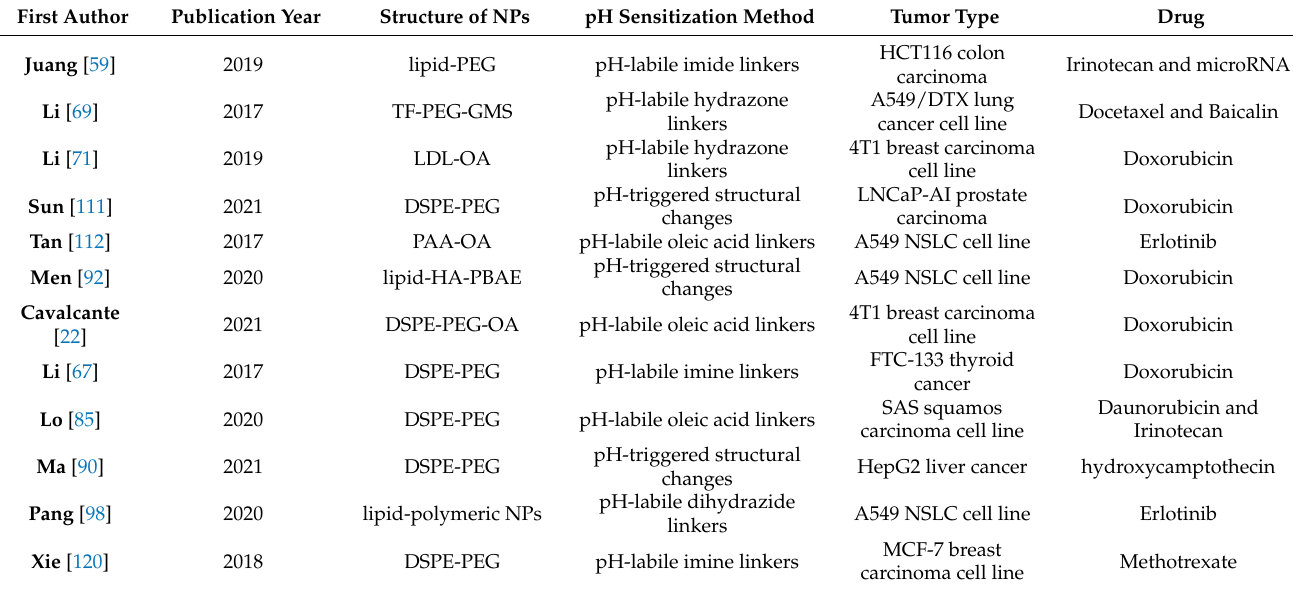
Table 6. Overview of lipid-based NPs: structure, pH sensitization method, tumor type, and delivered